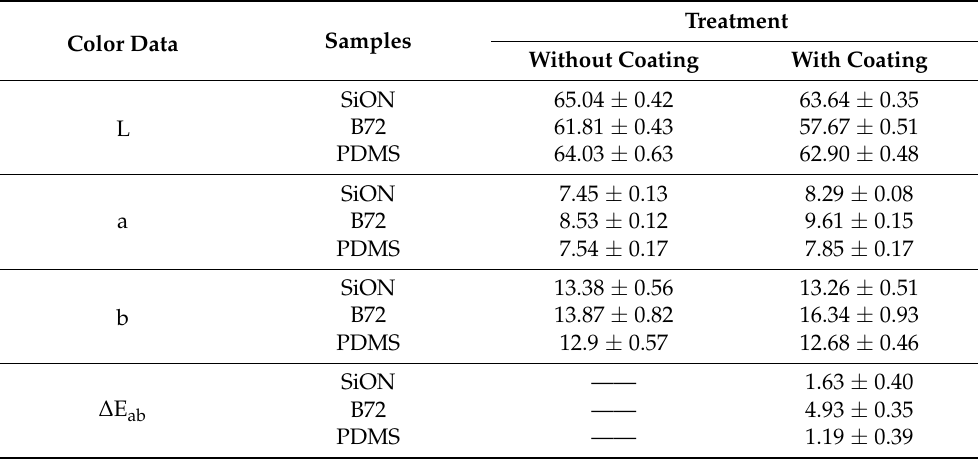
Table 2. Before and after treatment, chromaticity coordinates (L, a, and b) and global chromatic aberration data of the sandstone surface are shown.